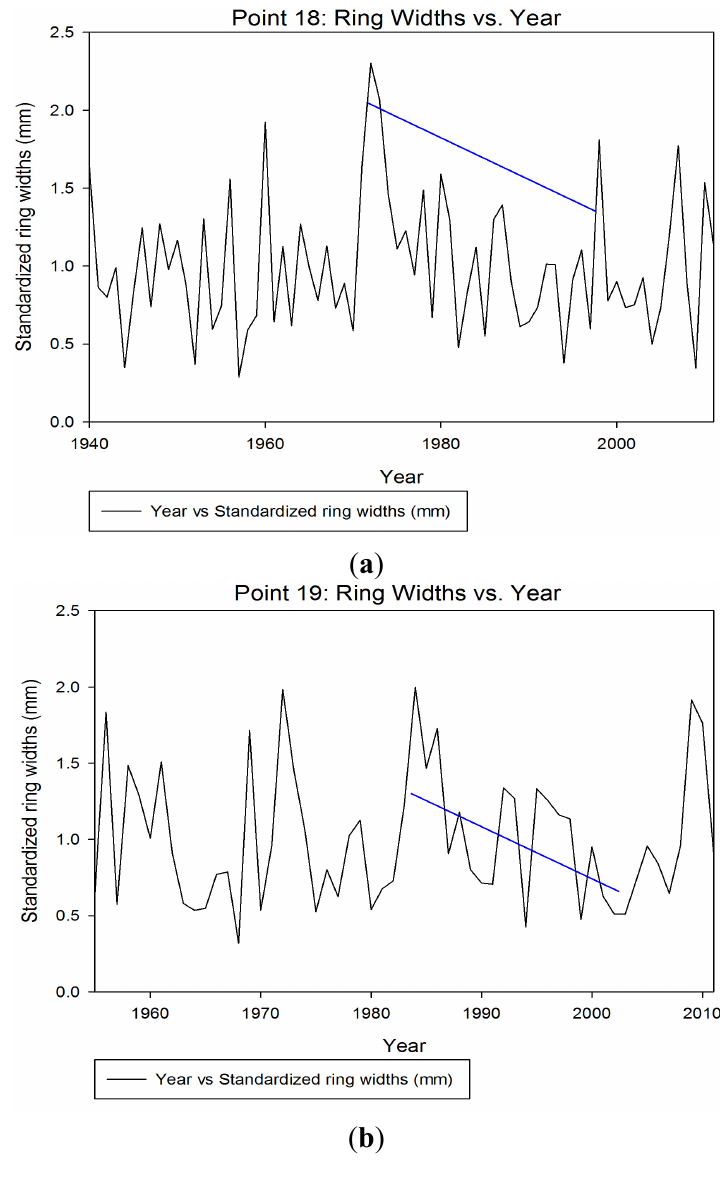
Figure 6. Standardized growth for Pterocarpus angolensis , Tsodilo Hills, Botswana. Hypothesized climate shift to dryer conditions in the early 1970s. Blue trend line indicated the mirrored patterns of decreased growth and decreased precipitation for ( a ) tree chronology Pt 18 and ( b ) tree chronology Pt